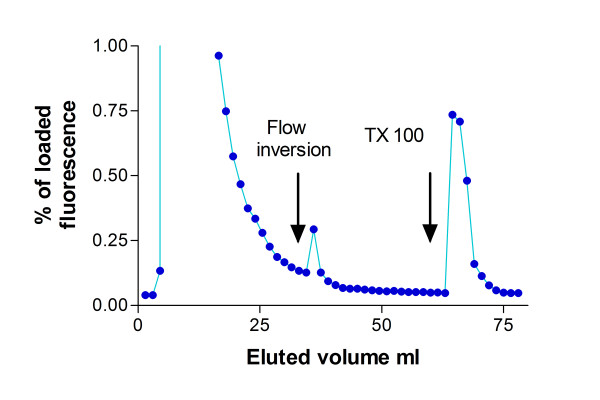
Flow inversion eluted a part of the retained liposomes. Liposomes were chromatographied on G25M. Fractions of 1.5 mL were collected. First arrows indicate the inversion of buffer flow and the second one the injection of 0.5% TX-100 on the top of the column.